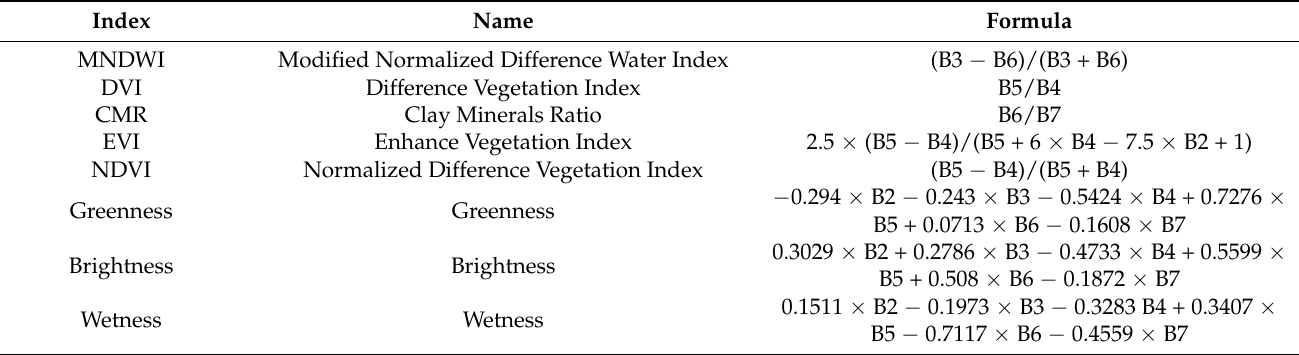
Table A2. Spectral exponential